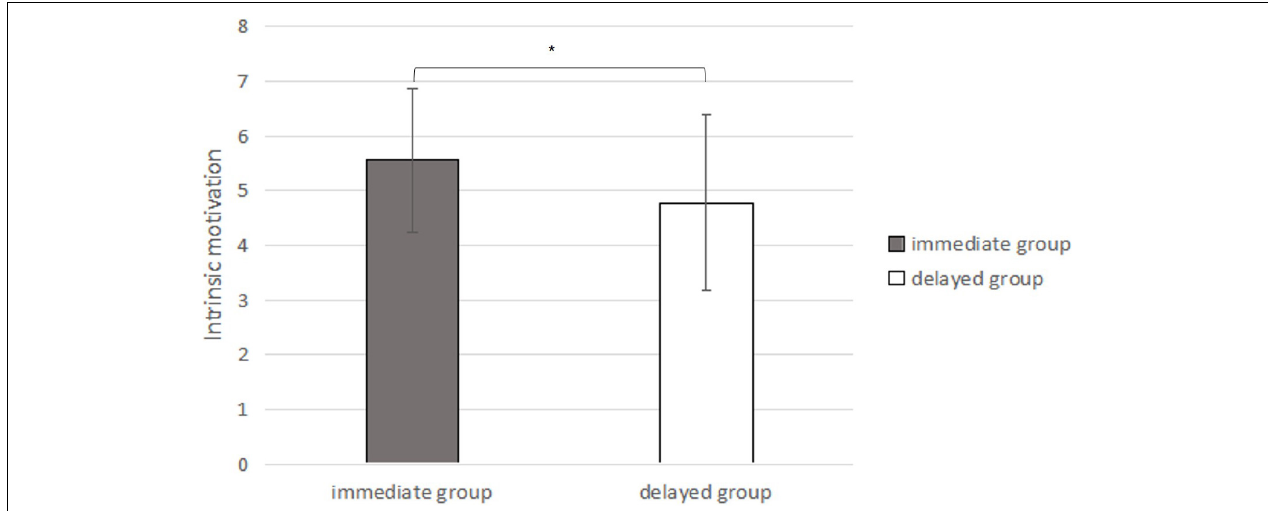
FIGURE 6 | First IMI scores under the original immediate extra reward and original delayed extra reward conditions (In the bar graph above, the error bars represent the standard deviations; ∗ represents p < 0.05).